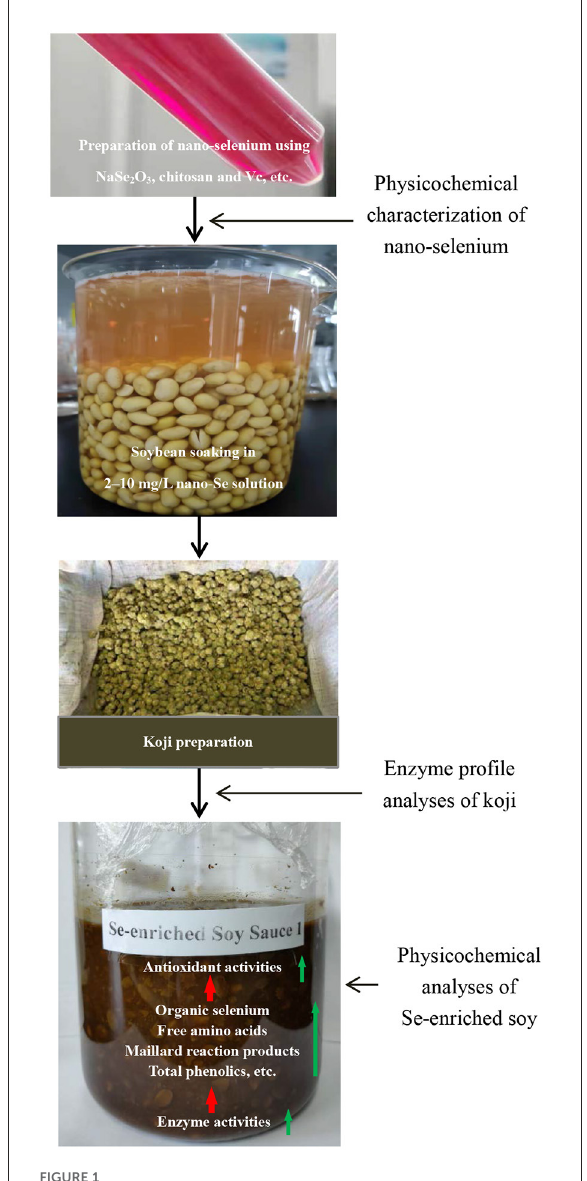
FIGURE1 Schematic overview of the experimental program.